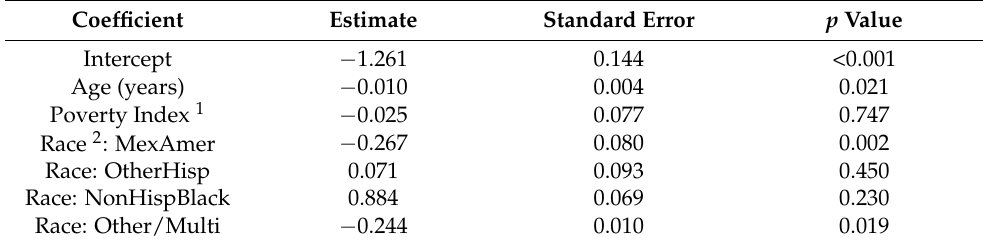
Table 4. Parameter estimates and p values from a linear regression model (using survey sampling weights) of log(SMRI HI ) in the women determined to be sufficiently similar to the reference